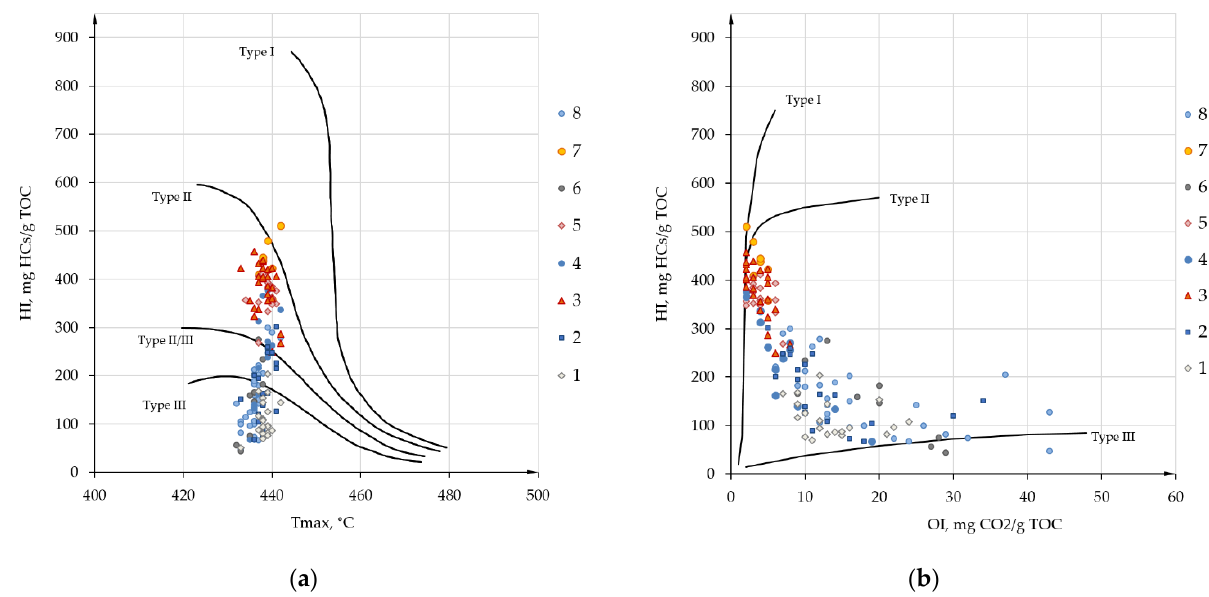
Figure 6. ( a , b ) Modified van Krevelen plots for the samples from the studied section. Red and orange markers are used for members #3, #5, and #7 (average TOC > 5 wt.%), grey and blue are for members #1, #2, #4, #6, and #8 (average TOC < 5 wt.%).